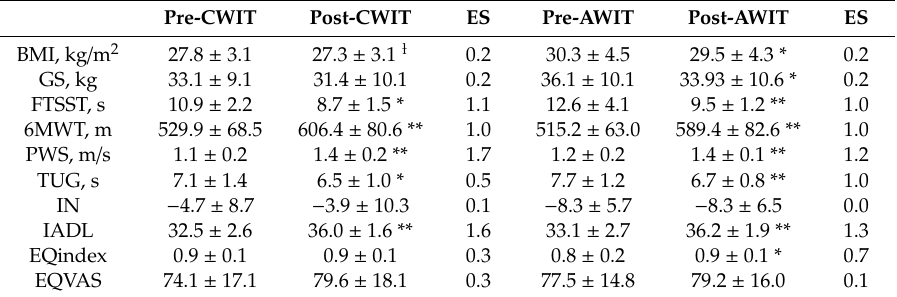
Table 4. Measures for continuous ( n = 11) and accumulated groups ( n = 12).